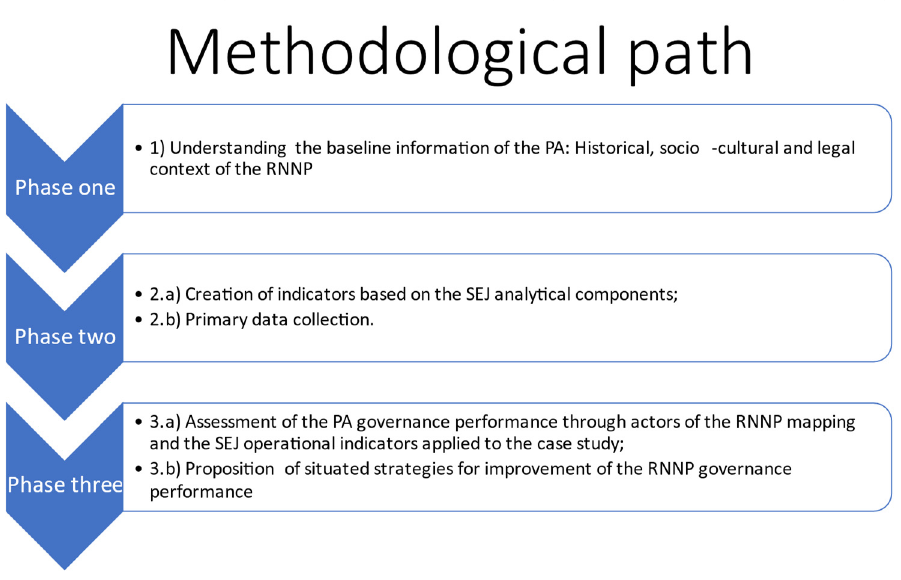
Figure 3. The methodological path to conduct this study.